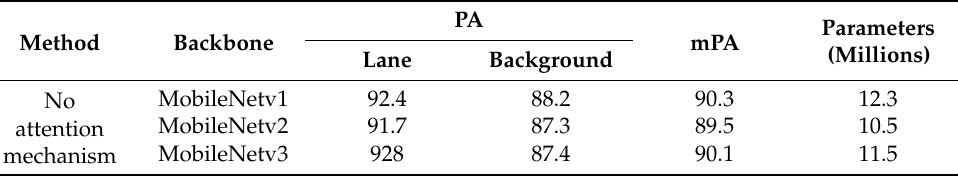
Table 5. Comparison of no attention module, CBAM module, and LRCA-Net in the lane detection